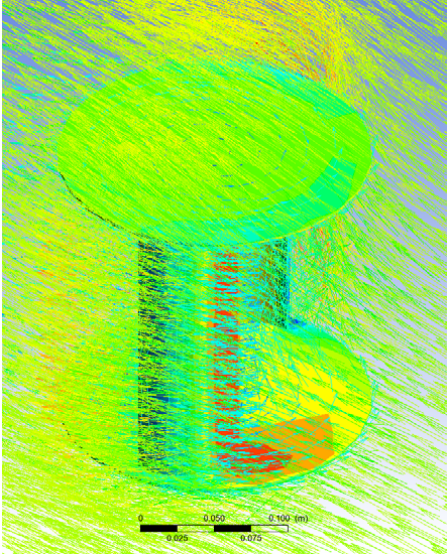
Figure 9. Velocity and pressure field for the Fibonacci I profile.